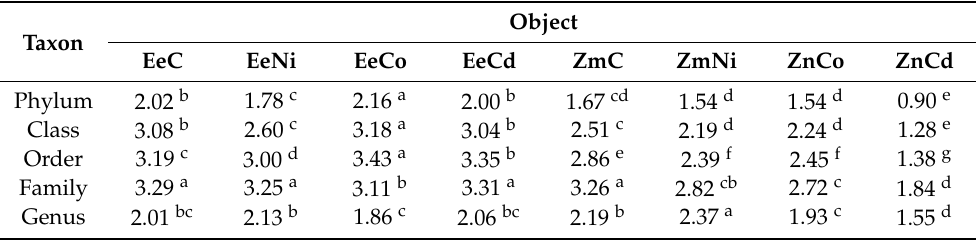
Table 2. Bacterial diversity in the soil polluted with heavy metals, expressed with the value of Shannon–Wiener index